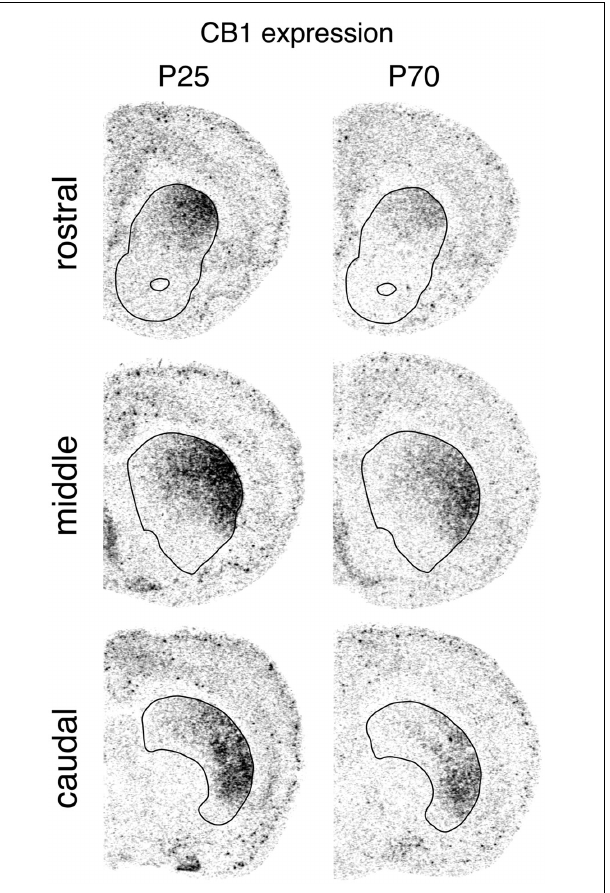
FIGURE 1 | Regional distribution of CB1 receptor expression in the striatum. Illustrations of film autoradiograms show distribution of CB1 mRNA in coronal sections from the rostral, middle and caudal striatum (outlined) in juvenile (P25) and adult (P70) rats.